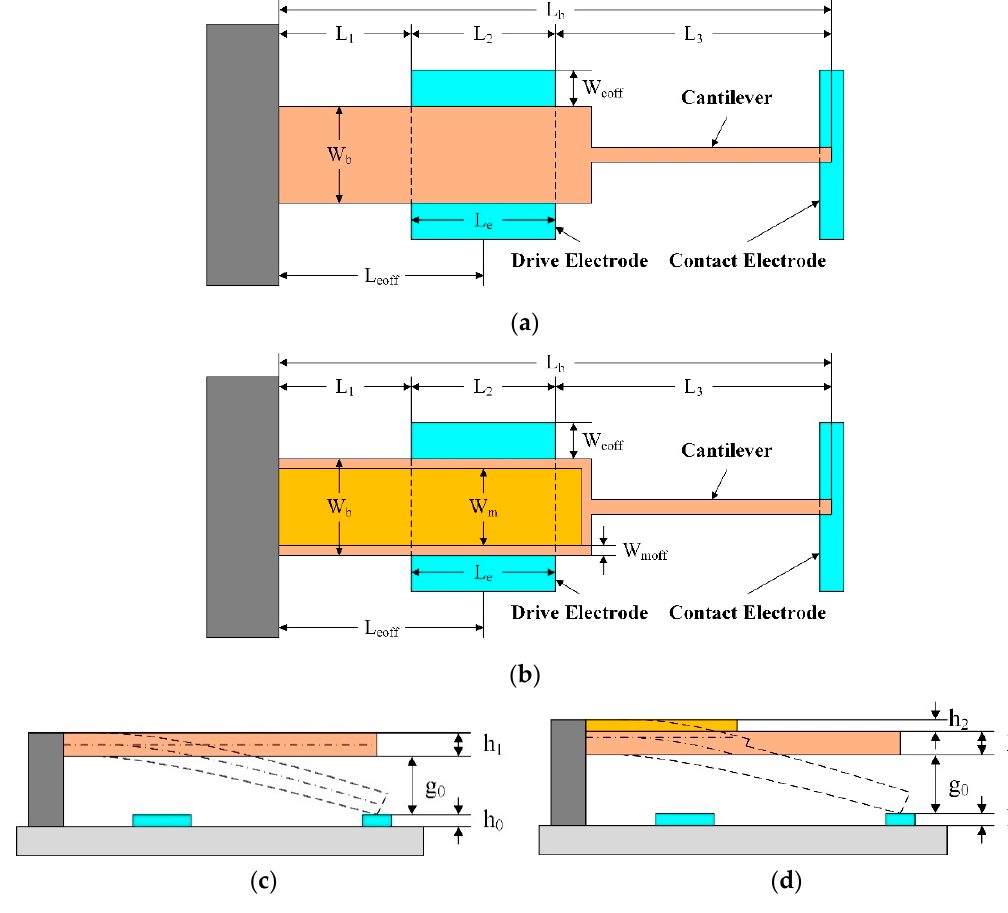
Figure 2. Dimensions in the test structure: ( a ) top view of test structure A; ( b ) top view of test structure B; ( c ) cross-sectional view of test structure A; and ( d ) cross-sectional view of test structure B.